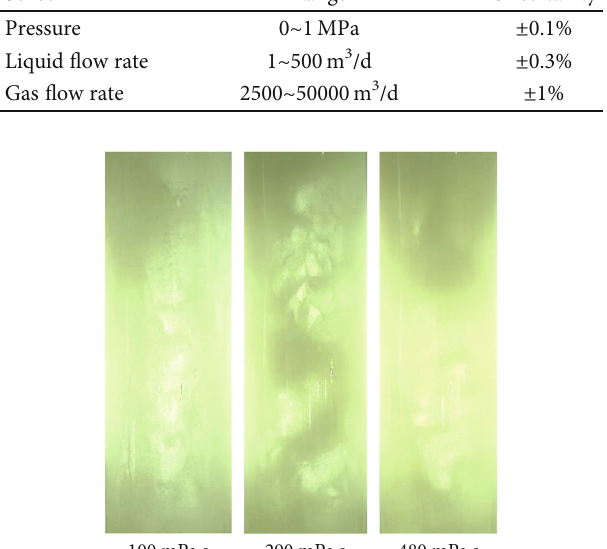
Table 2: Measurement parameters of di ff erent sensors. Sensor Range